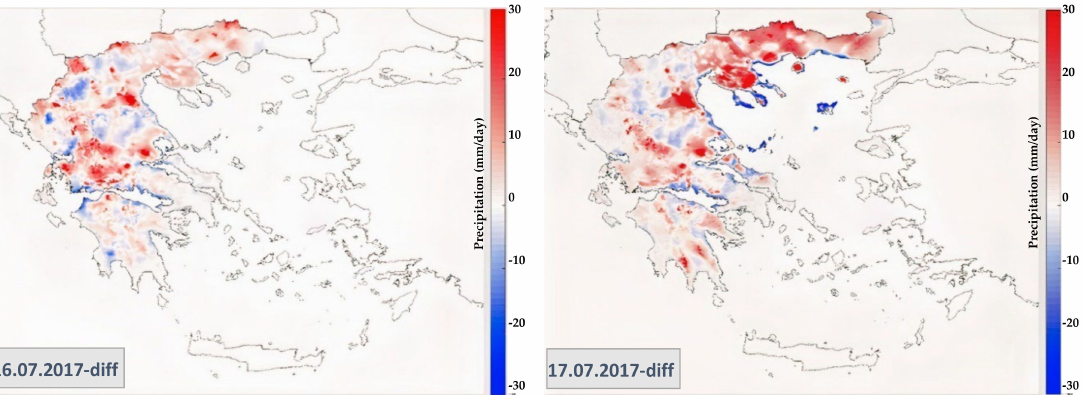
Figure 6. Differences in gridded observations of 24 h precipitation from MISH with/without H-SAF background for 16 July 2017 ( left ) and 17 July 2017 ( right ). Difference = (without background)—(with background), range: − 30 to